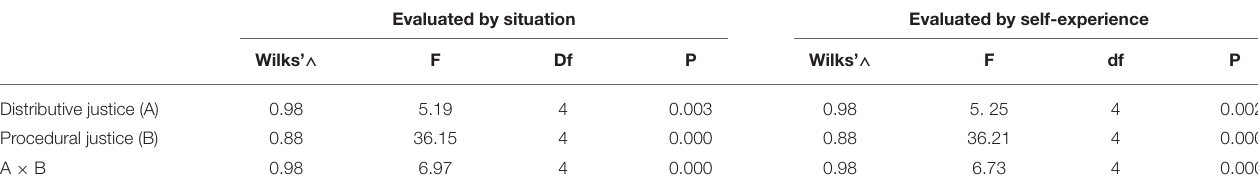
TABLE 6 | Full model analysis. Evaluated by situation Evaluated by self-experience